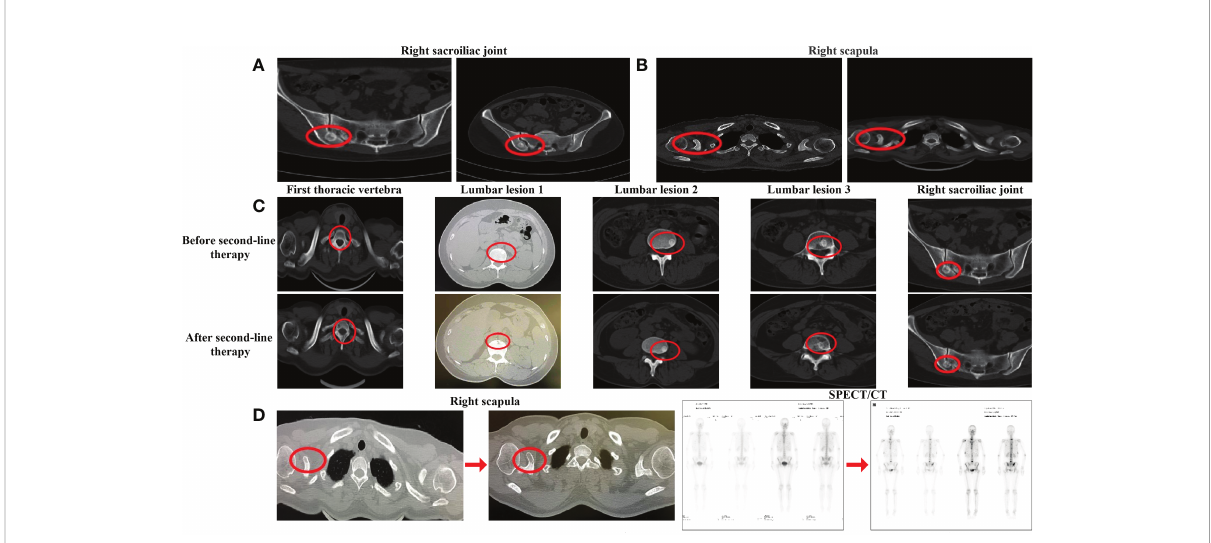
FIGURE 2 Evaluation after second-line chemotherapy. (A) CT evaluation of the right sacroiliac joint before chemotherapy and after cycles in December 2020. (B) CT evaluation of the right scapula before chemotherapy and after chemotherapy in May 2021 (C) CT evaluation of the bone lesion after second-line therapy in July 2021, (D) CT evaluation of the right scapula and SPECT evaluation after second-line therapy in July